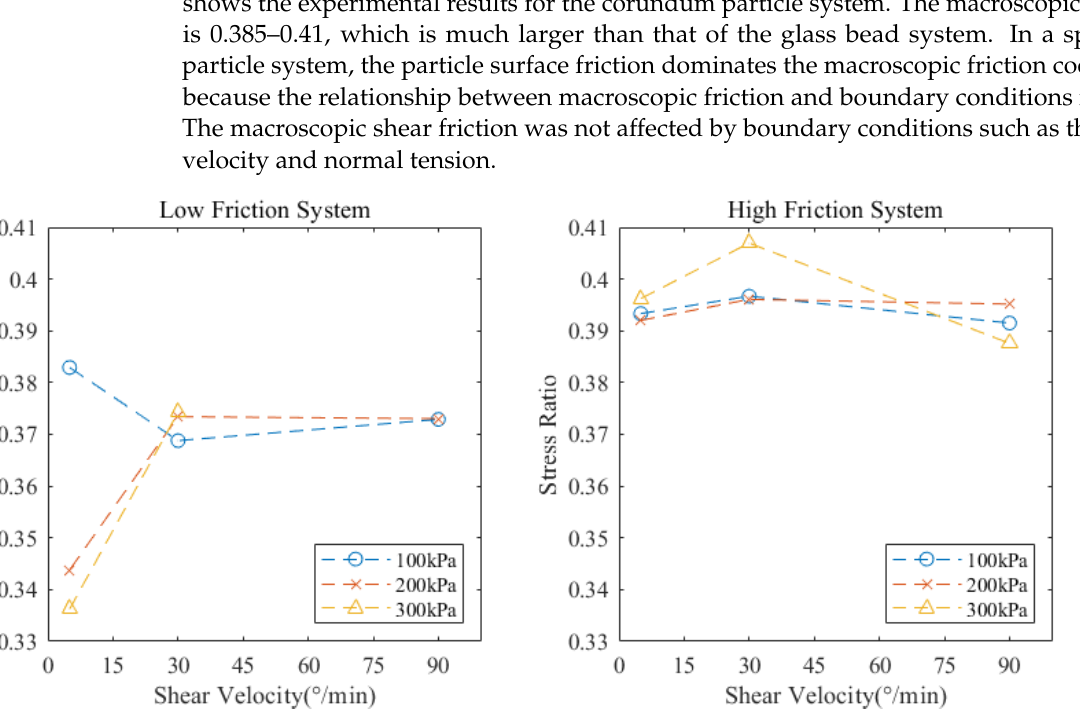
( b ) Figure 5. Relationship between shear velocity and stress ratio under different normal stresses. ( a ) Quartz sand; ( b ) Brecciated corundum. The macroscopic friction of a particle system is mainly determined by the particle form and surface friction, but not by the boundary conditions. The particle form is com- plicated, and the poor sphericity of the particles increases the system’s macroscopic fric- tion. In turn, higher particle surface friction increases the macroscopic friction of a spher- ical particle system. 3.3. Analysis of Macroscopic Frictional Fluctuation Characteristics of Particle System Figure 6 shows the investigation of the correlation of the macroscopic frictional fluc- tuation and shear velocity in the spherical particle system, where Figure 6a shows the glass microbead system and Figure 6b shows the brown corundum spherical system. The link between the shear velocity and the macroscopic fluctuation is low in the spherical